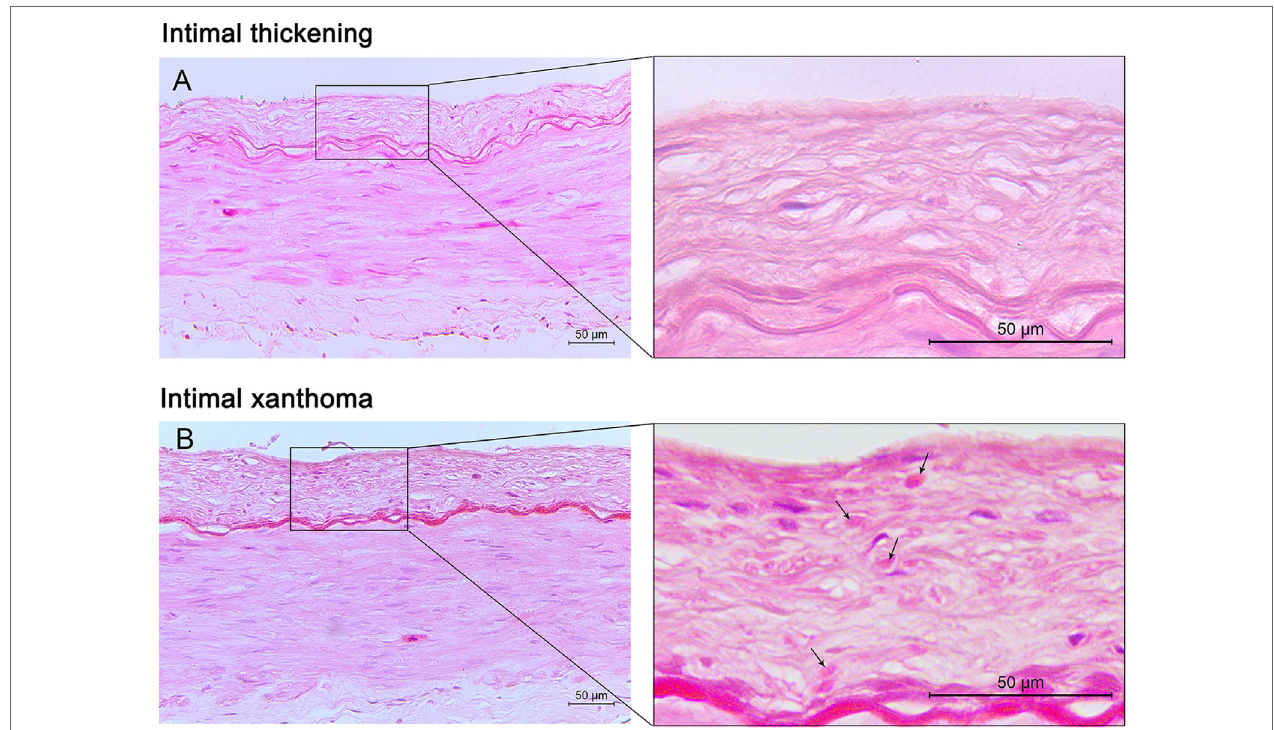
FigUre 1 | Pre-atherosclerotic intimal lesions. Intimal thickening (a) consists mainly of smooth muscle cells in a proteoglycan-rich matrix. Intimal xanthoma (B) displays intimal thickening with isolated foam cells (arrows). Hematoxylin and eosin (H&E) staining; original magnification: 10 × for original images, 40 × for inserted